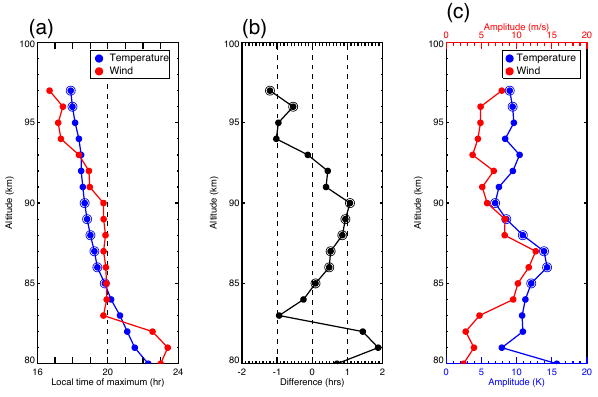
Figure 5. The local time maximum (a) , phase difference between temperature and wind oscillation (b) , and amplitude profile of the temperature and wind (c) . The red and blue circles denote wind and temperature data, respectively. The period is 4h. The double circles show values over the 99% significance